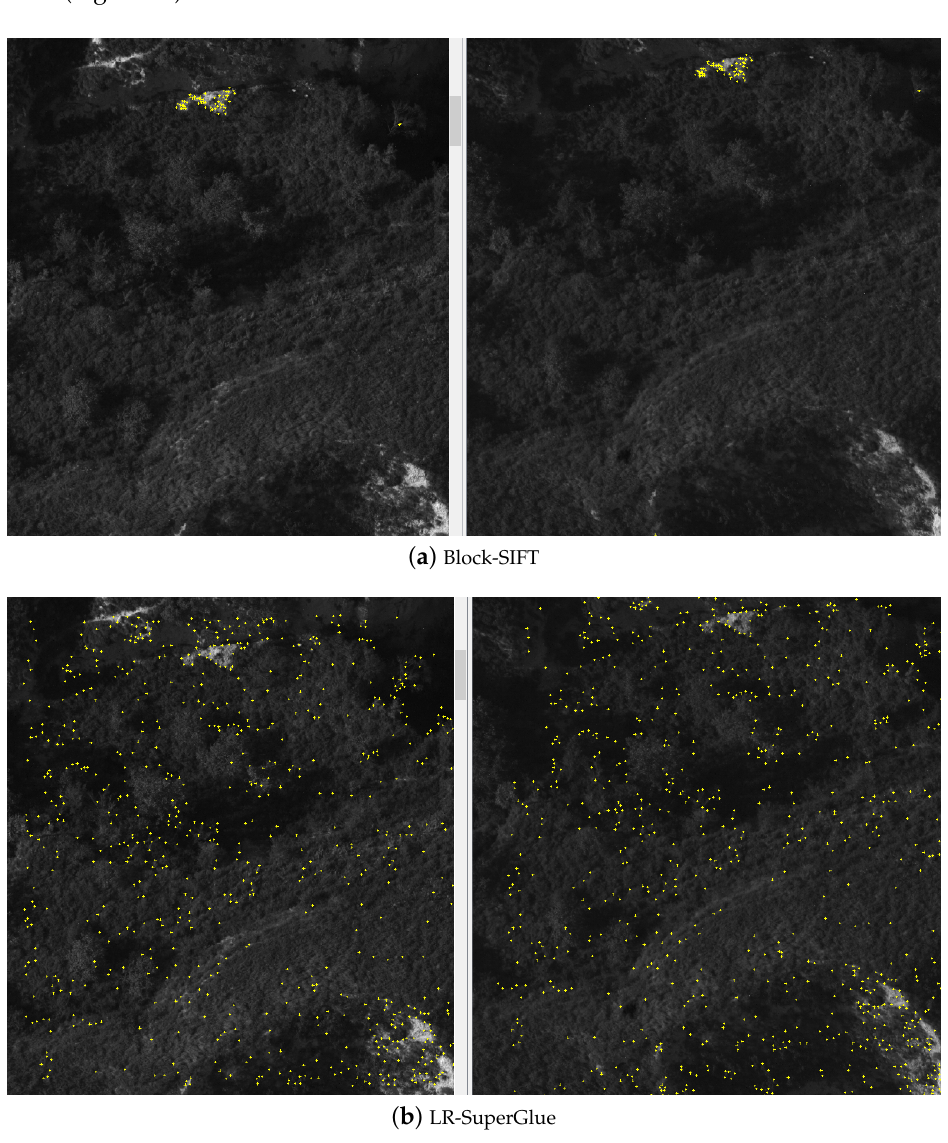
Figure 11. Matching reuslt of weak texture image: ( a ) There are only a few matching points (yellow “+”) by Block-SIFT method; ( b ) There are much more matching points by LR-SuperGlue